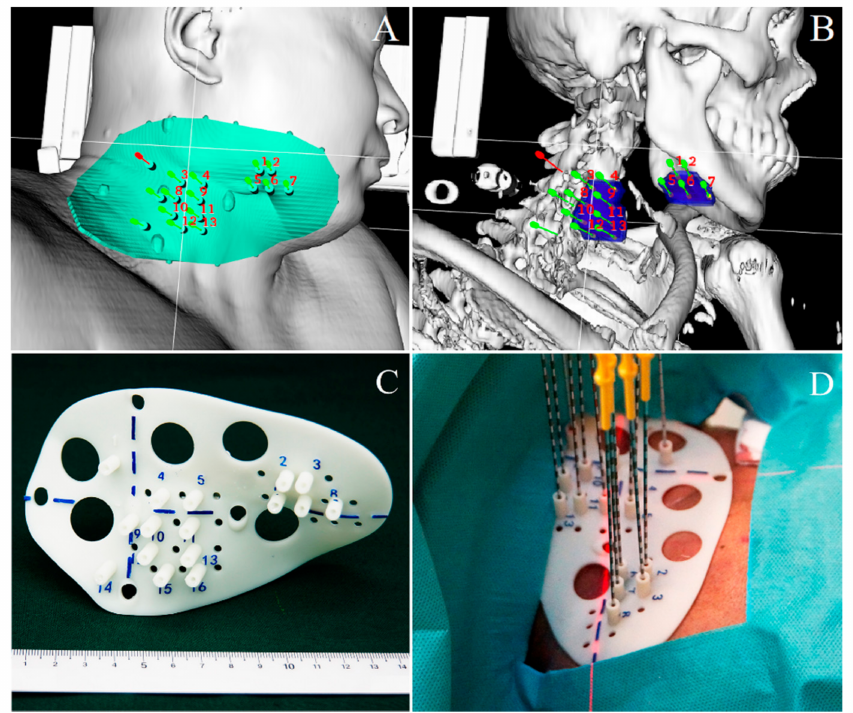
Figure 1. Three dimensional-printing templates (3D-PT) assisted individualized seed implantation. ( A , B ): Digital modeling of individualized 3D-PT in a patient with head and neck cancer; ( C ): The 3D- PT with 3 mm thickness contained information such as body-surface characteristics of the treatment area, localization markers, and an entrance hole for the 18-gauge needle; ( D ): 3D-PT was aligned to the therapeutic region, then needles were successfully